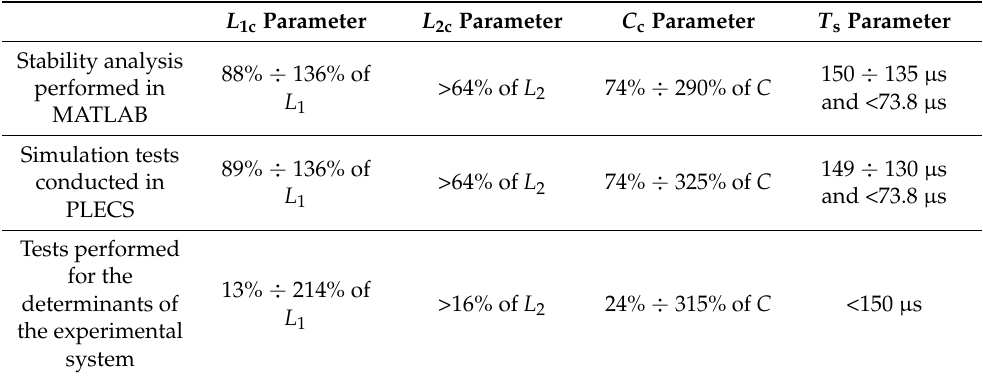
Table 2. Comparison of analytical and simulation stability limits of the